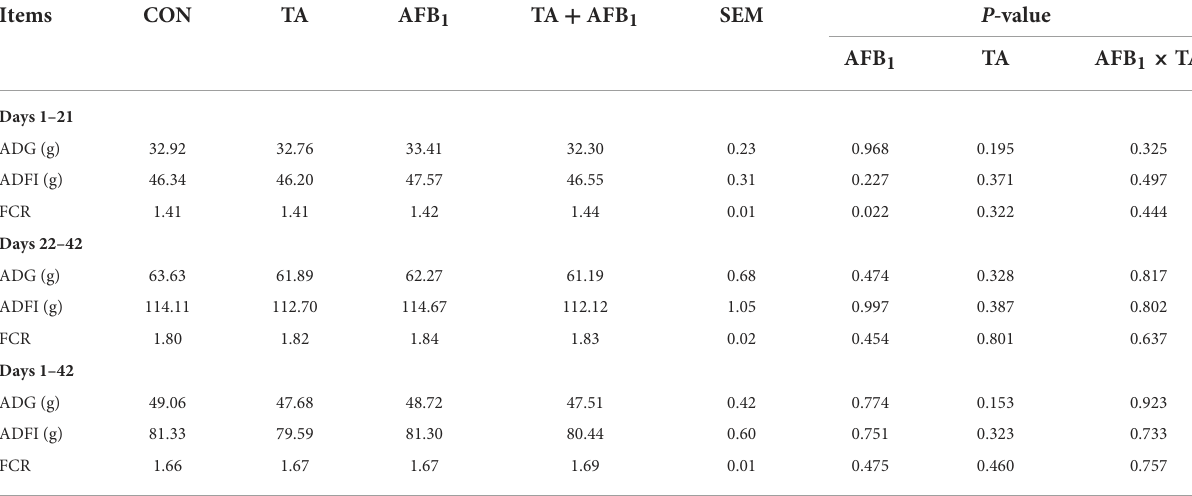
TABLE 2 Effects of tannic acid on growth performance of broilers challenged with AFB a 1 .